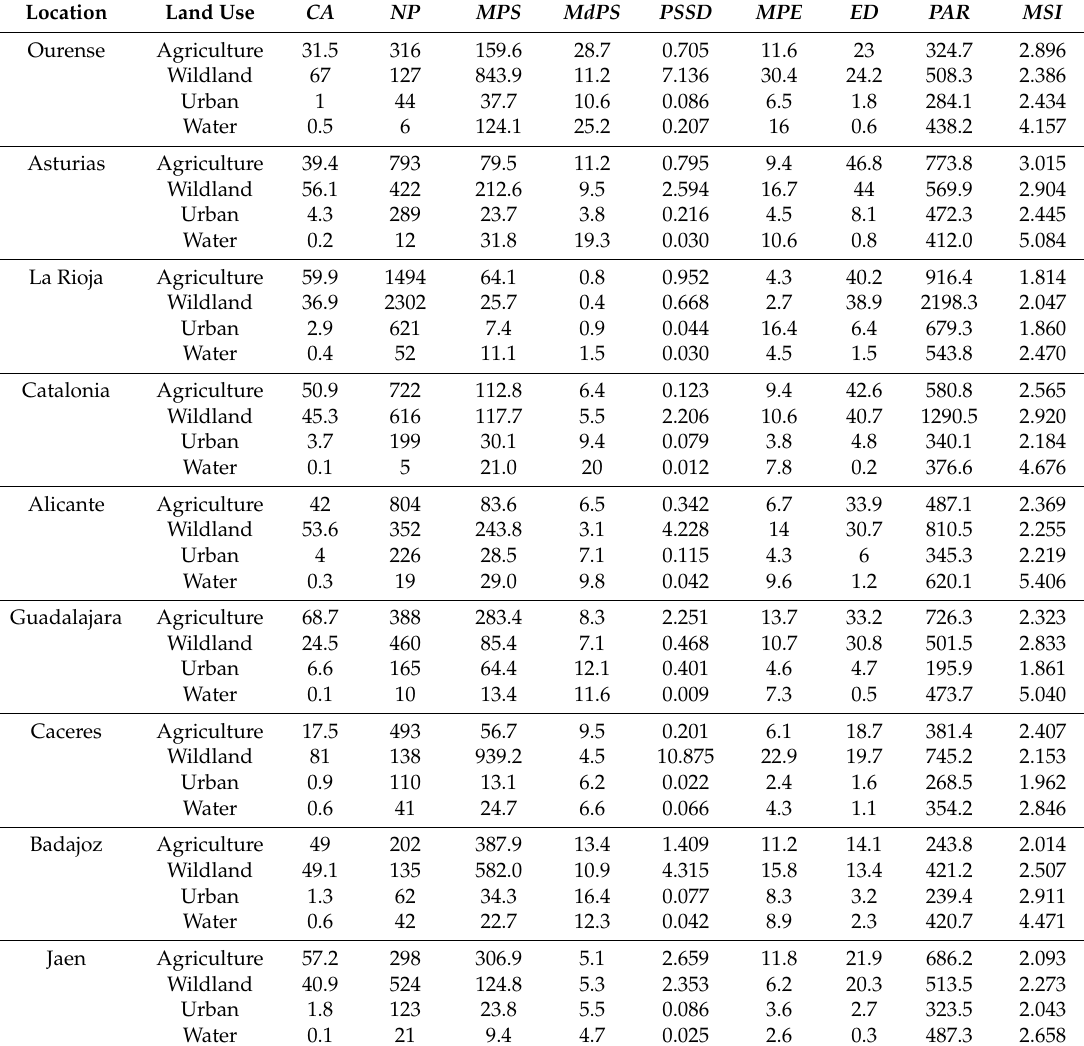
Table 2. Landscape ecology metrics at the land use class level by study